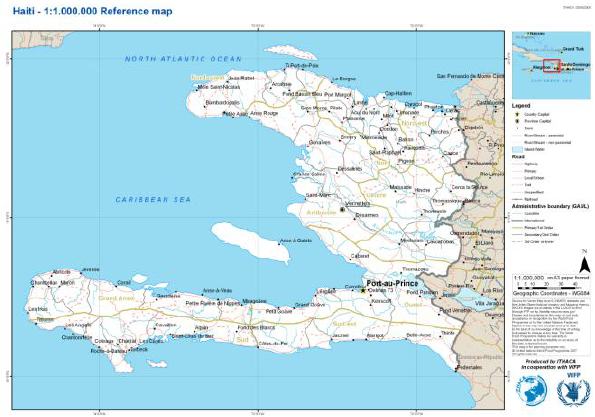
Figure 1. Haiti: 1:1.000.000 reference map